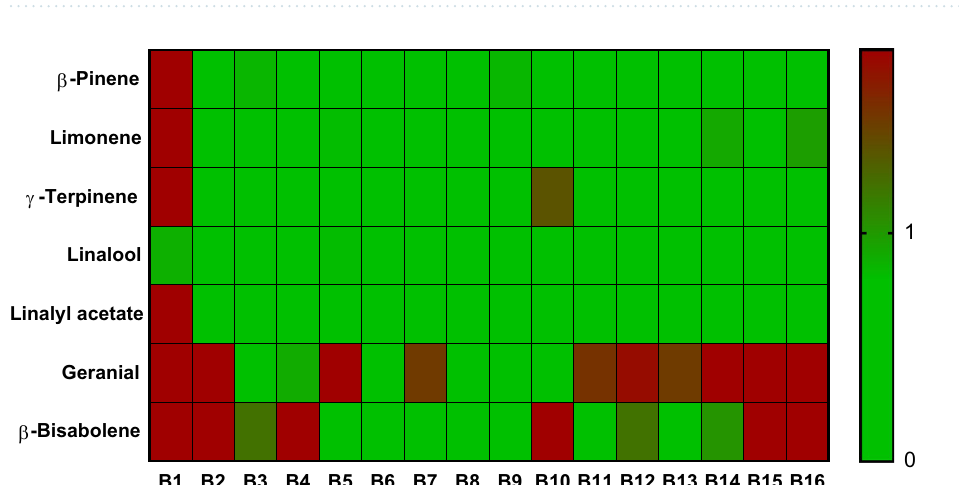
Figure 5. Heat map of relative scores of mandarin essential oils for relevant compounds according to ISO 3528. M12 and M13 were obtain from reputable source.